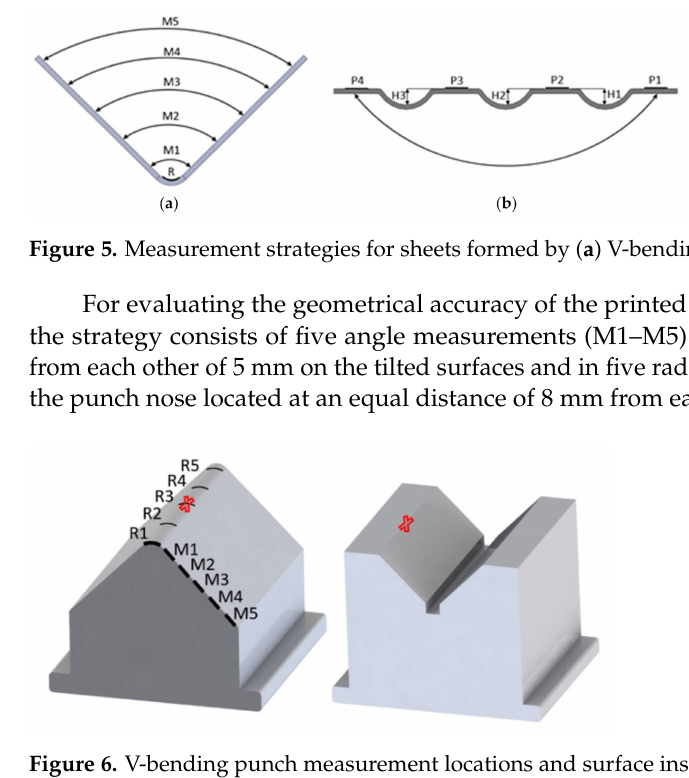
Figure 6. V-bending punch measurement locations and surface inspection locations (red marks) on both punch and